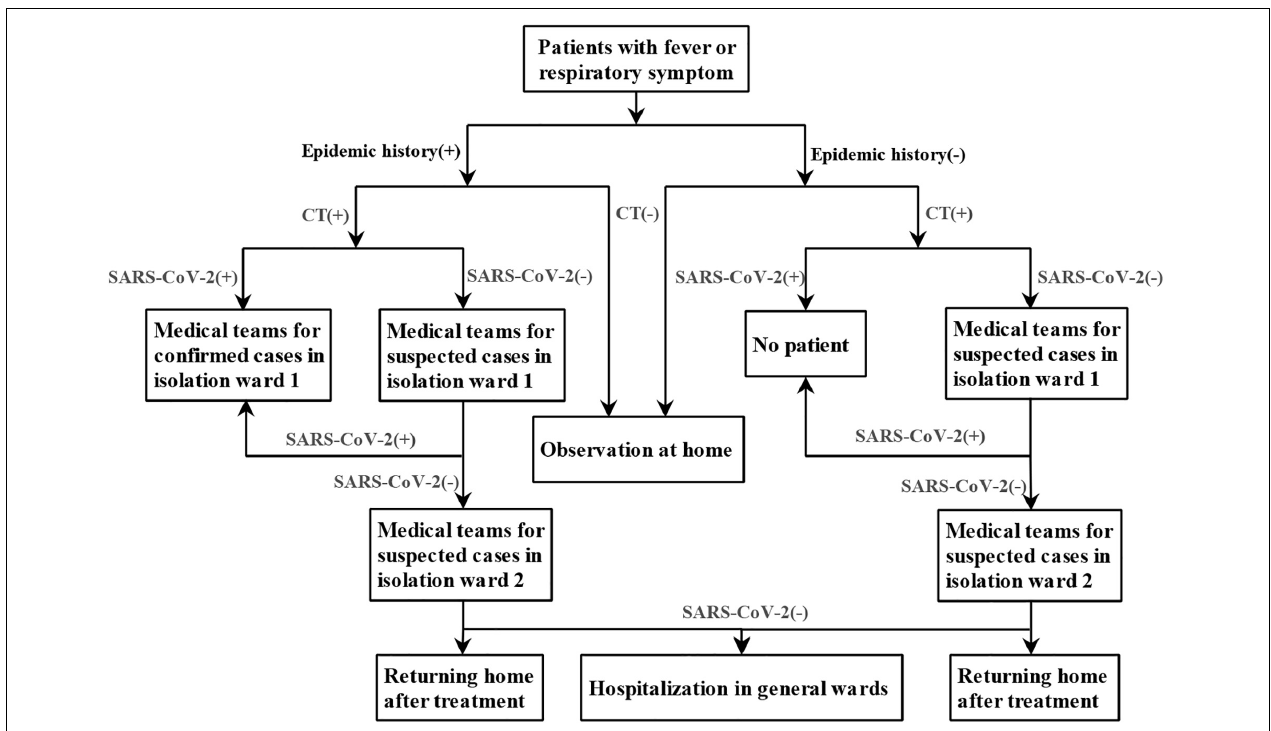
FIGURE 1 | The screening flowchart of COVID-19 in West China Hospital, Sichuan